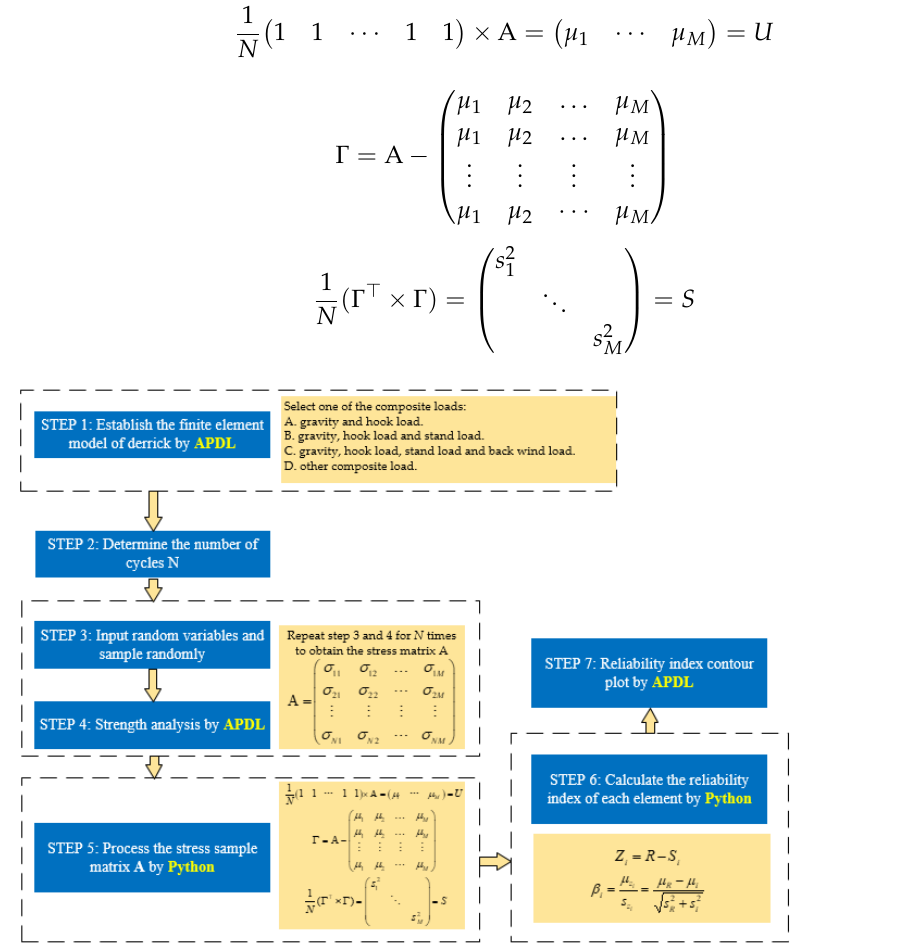
Figure 2. Flow chart of reliability analysis model of derrick under complex load.